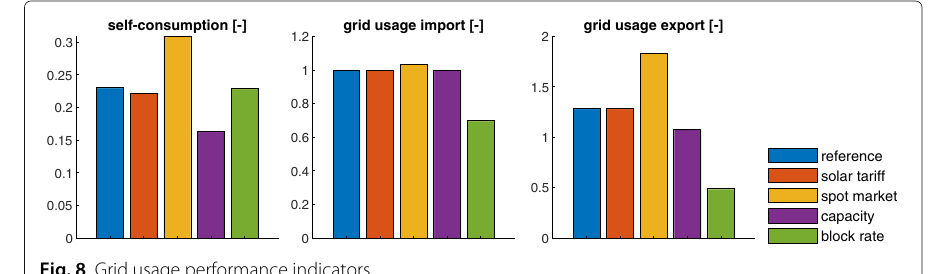
Fig. 8 Grid usage performance